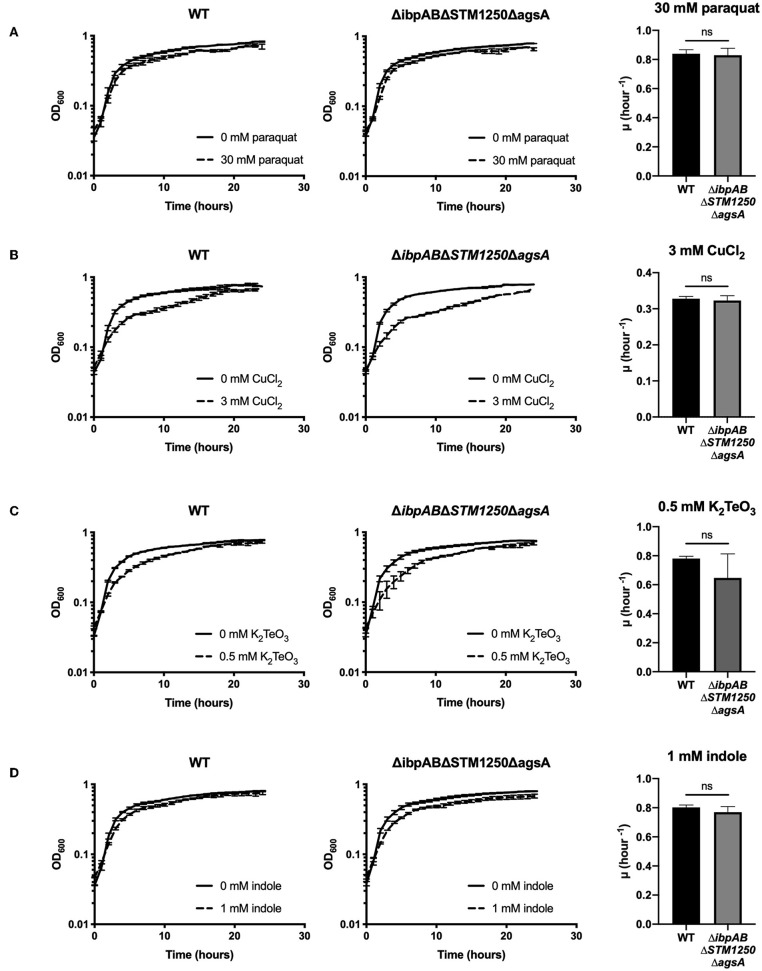
Deletion of ibpAB, STM1250, and agsA has no effect on overall growth or initial growth rate (μ hour−1) in the presence of 30 mM paraquat, 3 mM CuCl2, 0.5 μM K2TeO3, or 1 mM indole. Bacteria were grown in a plate reader at 37°C. Graphs show growth over 24 h or initial growth rate for WT and the quadruple mutant in the presence of (A) 30 mM paraquat (methyl viologen) (B) 3 mM CuCl2 (C) 0.5 μM K2TeO3 or (D) 1 mM indole. Data are the means of three separate experiments performed in duplicate. Error bars represent SEM. Data analyzed by one- way ANOVA with Tukey's multiple comparisons test, ns p > 0.05.